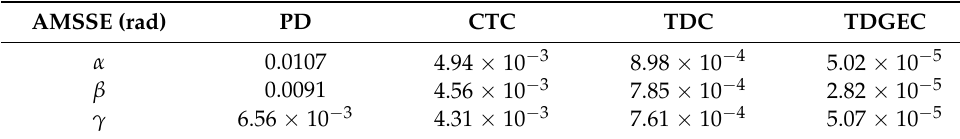
Figure 6. Simulation results: ( a ) Tracking curves ( r = 0.4) and ( b ) Tracking error curves ( r = 0.4). It can be observed from Figure 6a that under the condition of 40% model uncertainty, the trajectory tracking using the TDGEC algorithm fits the desired trajectory well. In addition, the tracking error curves show that the error change of the system using the TDGEC algorithm is more stable. Under 40% modeling error, using four control algorithms, the absolute of the Max Steady-State Error (AMSSE) in three directions is shown in Table 2. The AMSSE values of using the TDGEC method are 5.02 × 10 − 5 rad, 2.82 × 10 − 5 rad, and 5.07 × 10 − 5 rad, which are much smaller than those of the other three controllers. Table 2. AMSSE values.